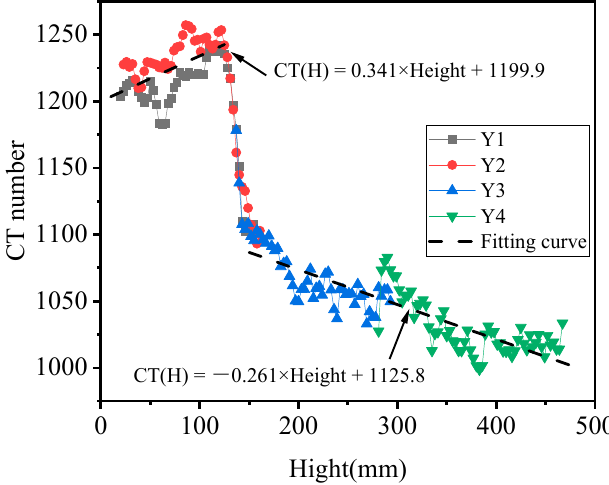
Figure 14. Distribution of CT number along